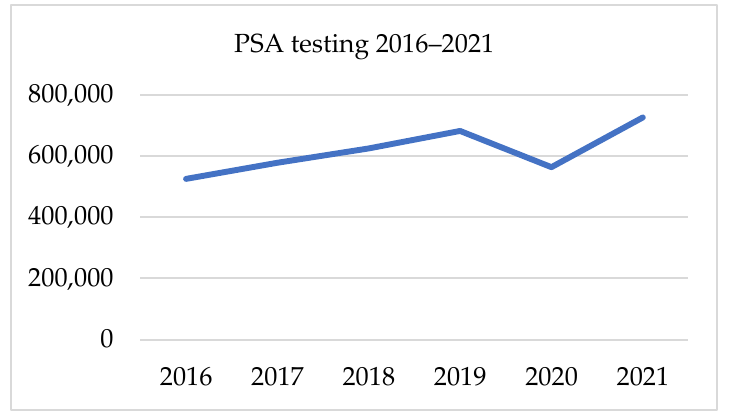
Figure 5. PSA testing in 2016 – 2021.